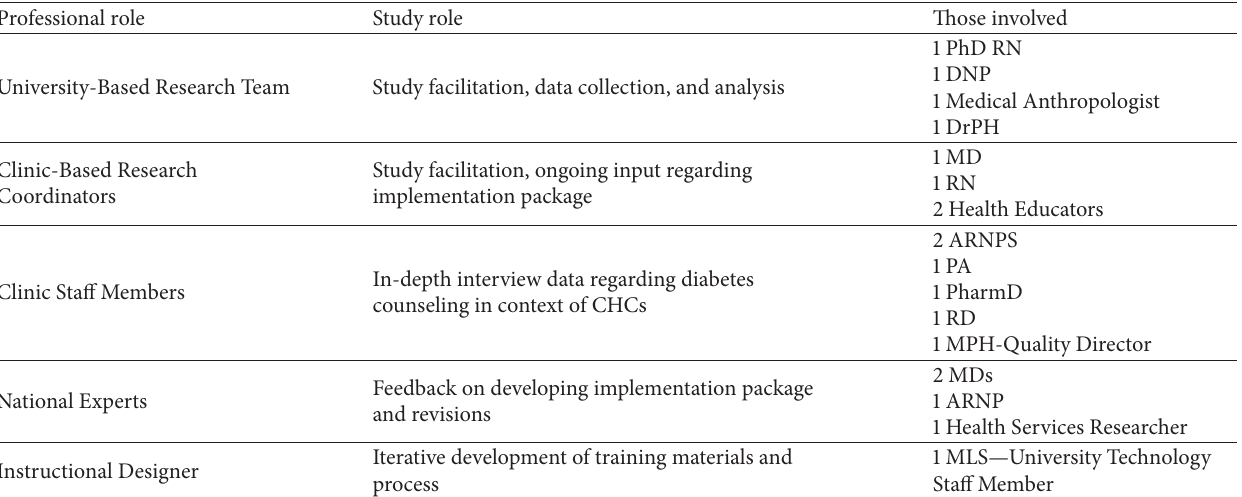
Table 1: Parties involved in development